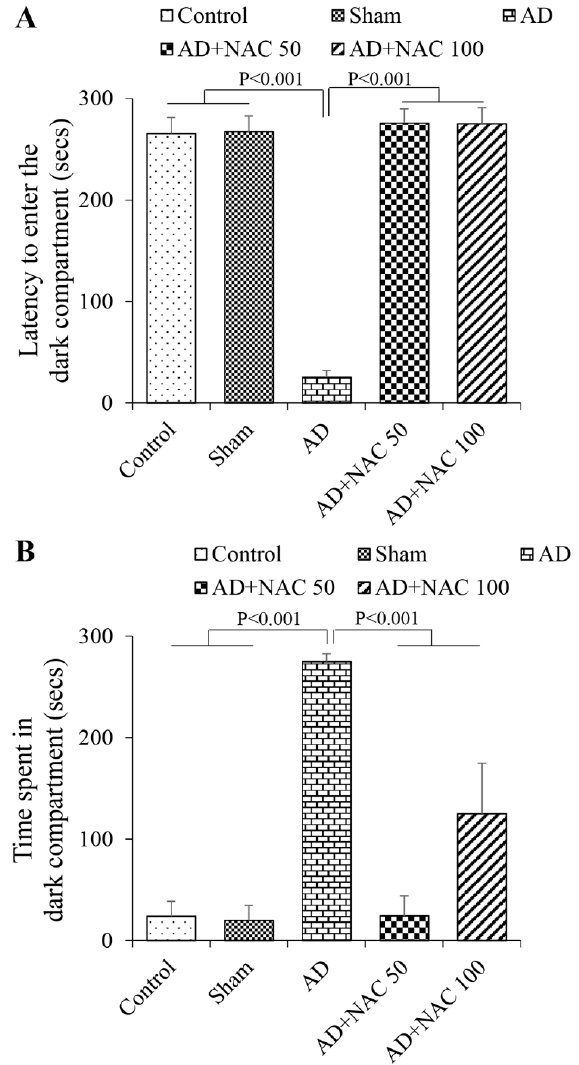
Figure 1. Performance of the rats in the passive avoidance task. ( A ) Latency to enter the dark compartment; ( B ) Time spent in the dark compartment during the retention test by the rats in different groups (Control, Sham operated, AD model (received intraventricular colchicine), AD + NAC 50 (AD model rats received 50 mg/kg of NAC, AD + NAC 100 (AD model rats received 100 mg/kg of NAC). Note that AD model rats had significantly shorter latencies to enter the dark compartment compared to control and sham group, and they were significantly higher in AD + NAC treated groups. Similarly, AD rats spent significantly more time in the dark compartment compared to control and sham groups, and time spent in dark compartment significantly decreased in the AD + NAC groups compared to the AD group (One-way ANOVA, Bonferroni’s multiple comparison test, n = 6 in all groups).